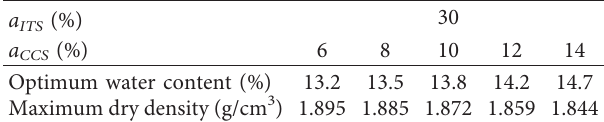
Table 5: Compaction